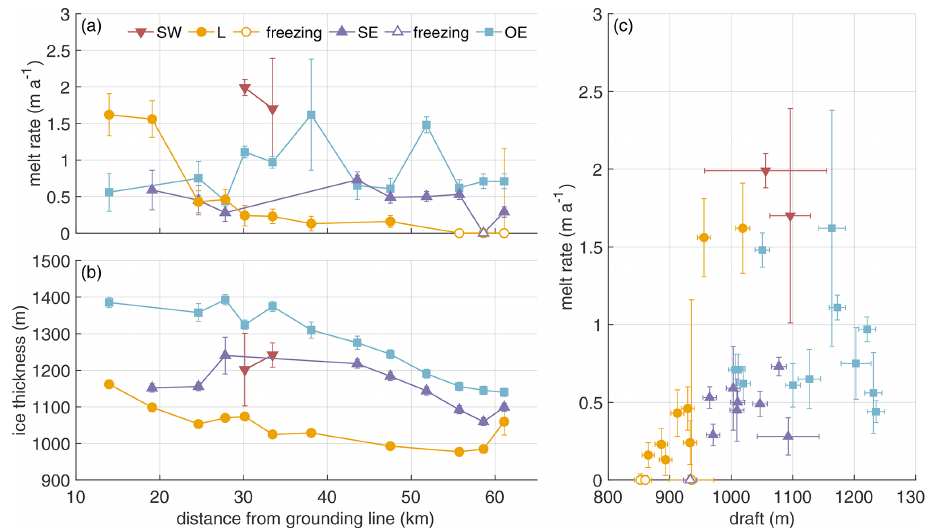
Figure 2. Spatial distribution of pRES-derived (a) basal melt rates (positive a b represents melting) and (b) ice thickness at the locations SW (red), L (yellow), SE (purple) and OE (blue) around the channel as a function of distance from the grounding line. (c) Melt rate as a function of ice draft obtained from pRES-derived ice thickness and h TDX